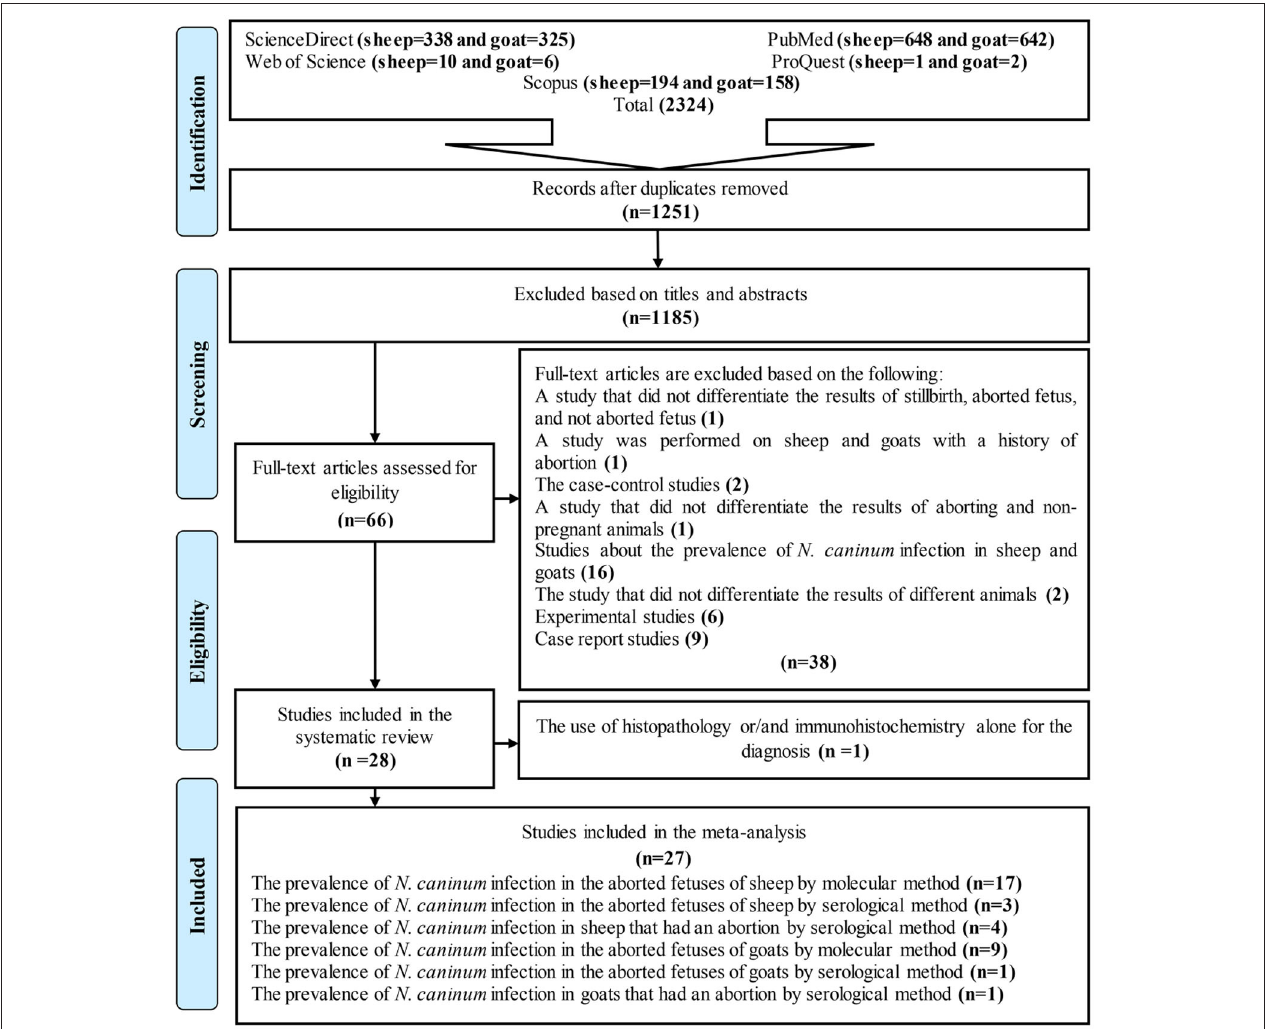
FIGURE 1 | Flow diagram of the study design process.